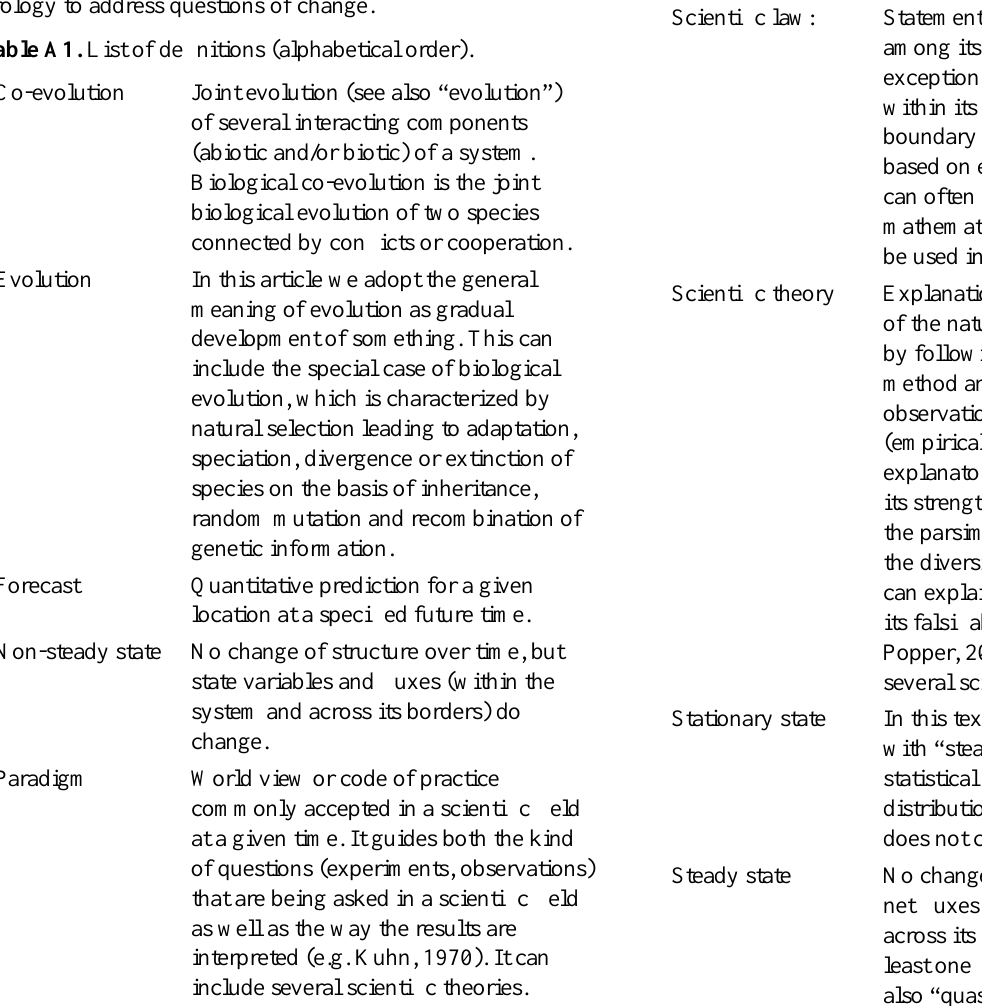
Table A1. List of definitions (alphabetical